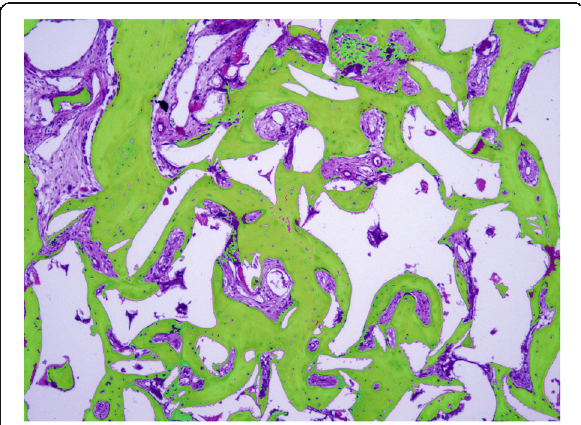
Fig. 1 Histomicrograph illustrating the various tissue areas measured on the sections: newly formed bone ( green mask ), soft tissues ( purple mask ), and “ others ” , including residual bone substitute particles and empty spaces either due to removal of the bone substitute particles during to the decalcification processing or due to artifacts ( white mask